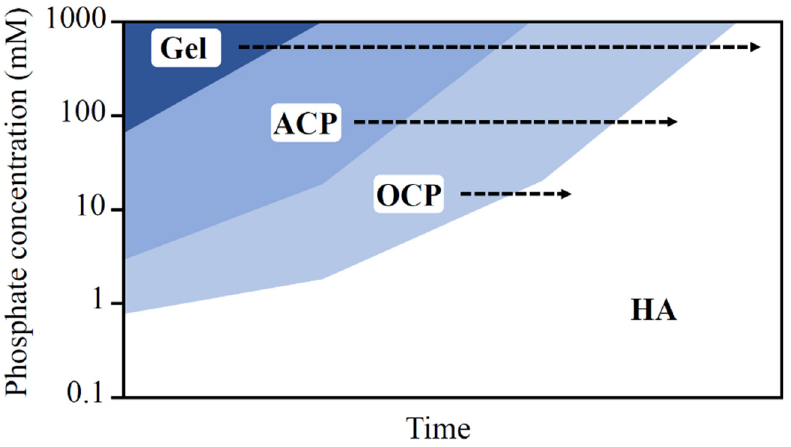
Figure 8. The formation, stability, and hydrolysis of calcium phosphates as a function of phosphate concentration (log (P)) in solutions at neutral pH [87].